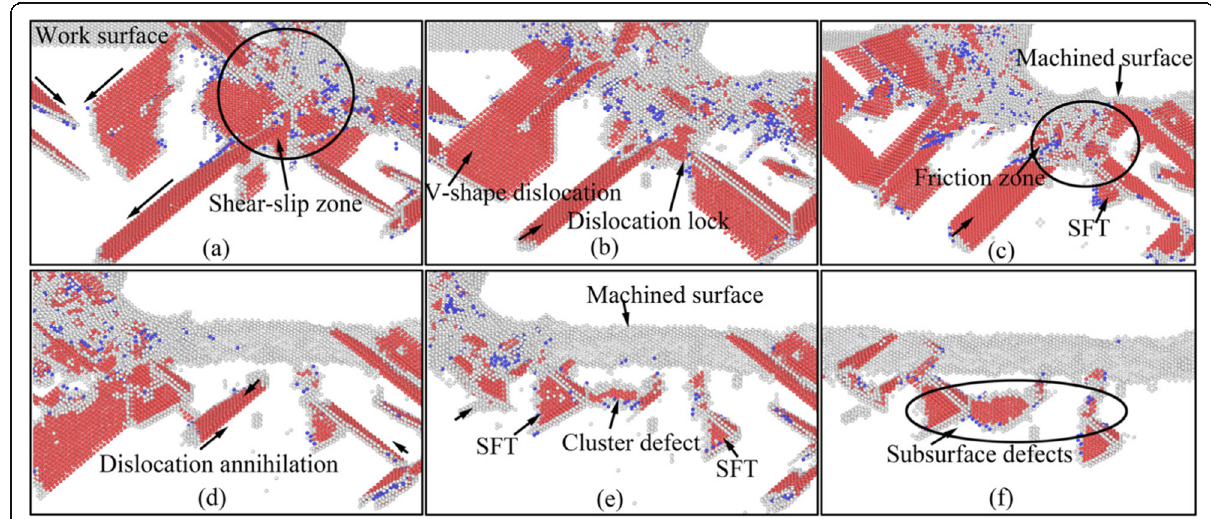
Fig. 4 Subsurface defects evolution of workpiece (color online). The cutting distances of a , b , c , d , e , and f respectively are 8 nm, 10 nm, 12 nm, 20 nm, 24 nm, and 32